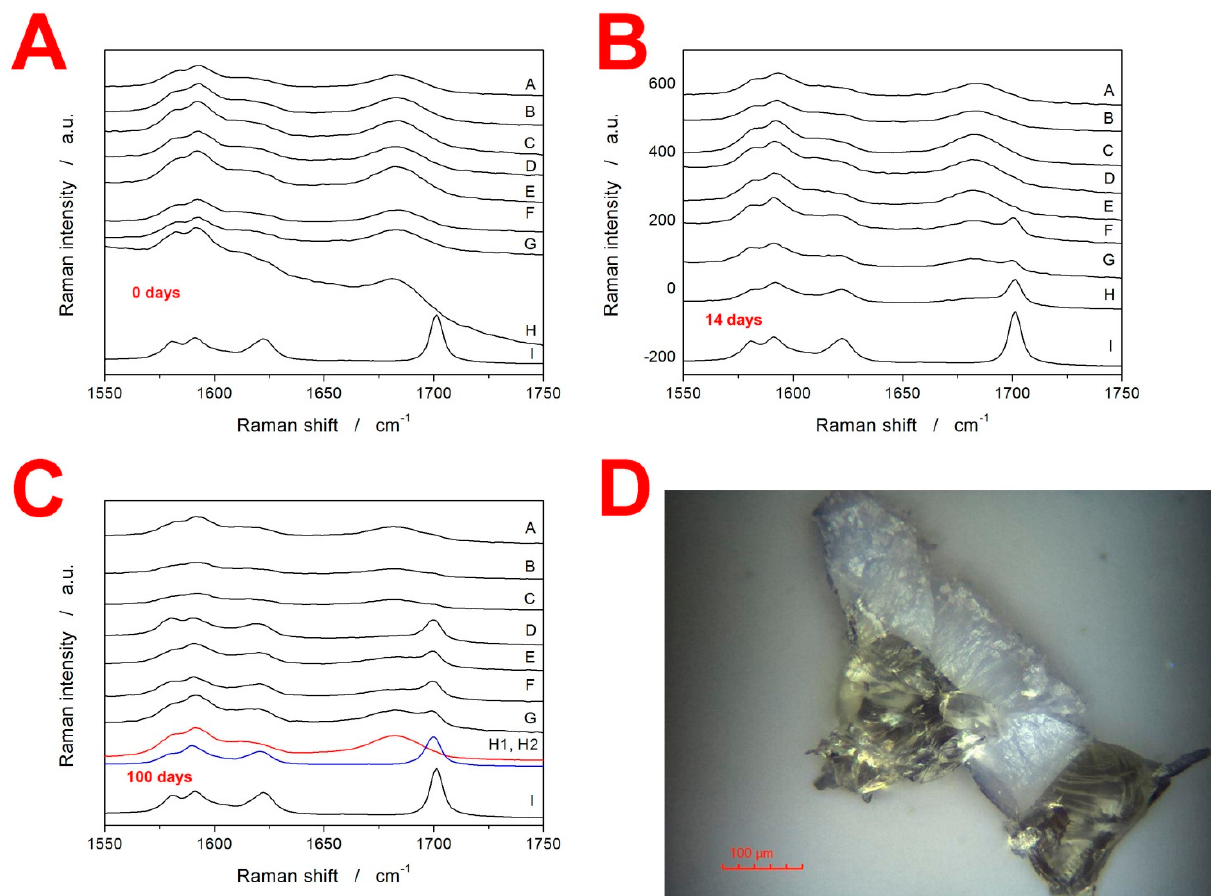
Figure 4. ( A – C ) Raman spectra of IMC powders stored for 0, 14, and 100 days at laboratory temperature and humidity. The notation of the spectra is as follows: (A) 20–50 µm, (B) 50–125 µm, (C) 125–180 µm, (D) 180–250 µm, (E) 250–300 µm, (F) 300–500 µm, (G) bulk (~500–1000 µm), (H) true bulk IMC formed as a droplet of molten IMC being allowed to cool/freeze-in on a microscopy slide, and (I) initial as-purchased IMC powder used to prepare the amorphous IMC. In graph ( C ), two spectra are displayed for sample H—one for the formed crystal and one for the free smooth surface. ( D ) Optical micrograph of a bulk sample stored for 100 days at 10 °C. The sample was then gently broken; the micrograph shows two pieces on the cross-section. The pale/white parts represent the surface crystalline layer formed by the GC growth mechanism.